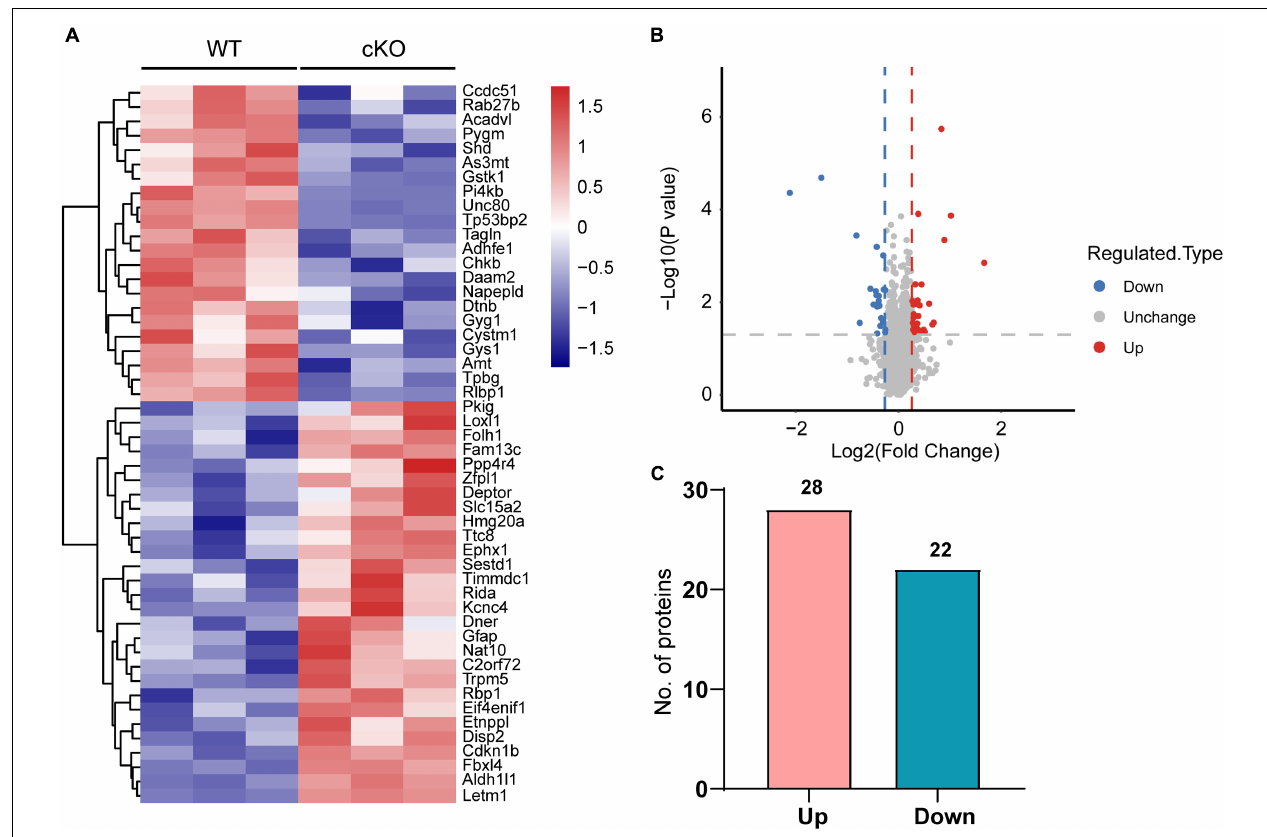
FIGURE 3 | Differentially expressed proteins in the mPFC of astrocytic OGT knockout and WT mice. (A,B) Heatmap (A) and volcano plots (B) of differentially expressed proteins in the mPFC of astrocytic OGT knockout and WT mice. (C) Number of up- and downregulated proteins in the mPFC.